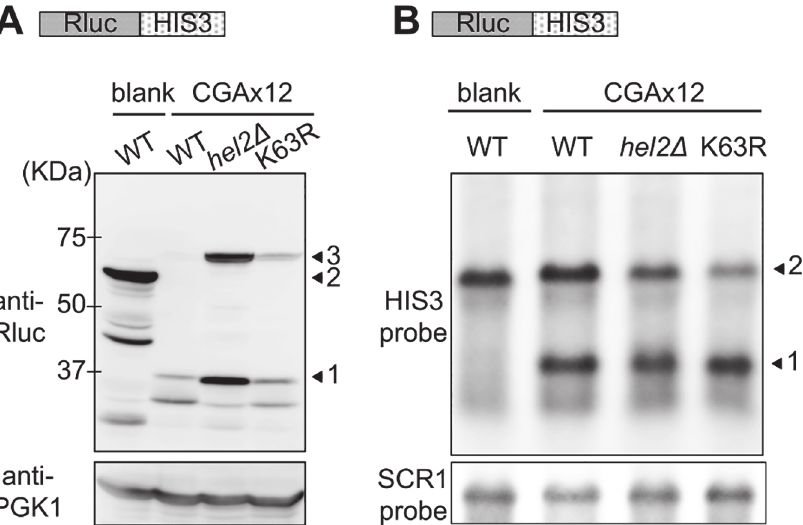
Fig 3. Comparison of the effects of Hel2 deletion and K63R expression on protein and mRNA levels in stalled translation. (A) Western blot analysis for the effects of K63R ubiquitin on Rluc-HIS3 reporter. blank indicates the result of the Rluc-blank-HIS3 reporter, and CGAx12 indicates the results of the Rluc-CAAx12-HIS3 reporter. WT indicates the wild-type strain (BY4727) without K63R ubiquitin, hel2 Δ indicates the hel2 Δ strain (SKY61), and K63R indicates the wid-type strain expressing K63R ubiquitin. Arrowhead 1 indicates the Rluc protein alone, arrowhead 2 indicates the Rluc-blank-HIS3 protein, and arrowhead 3 indicates the Rluc-CGA x12-HIS3 protein. PGK antibody was used as loading control. (B) Northern blot analysis for the effects of K63R ubiquitin on Rluc-HIS3 reporter. blank and CGAx12 as well as WT, hel2 Δ , and K63R are as in (A). The reporter mRNA was probed by HIS3 complementary DNA fragment. Arrowhead 1 indicates the cleaved HIS3 mRNA and arrowhead 2 indicates the full-length mRNA. SCR1 mRNA was detected as a loading control.